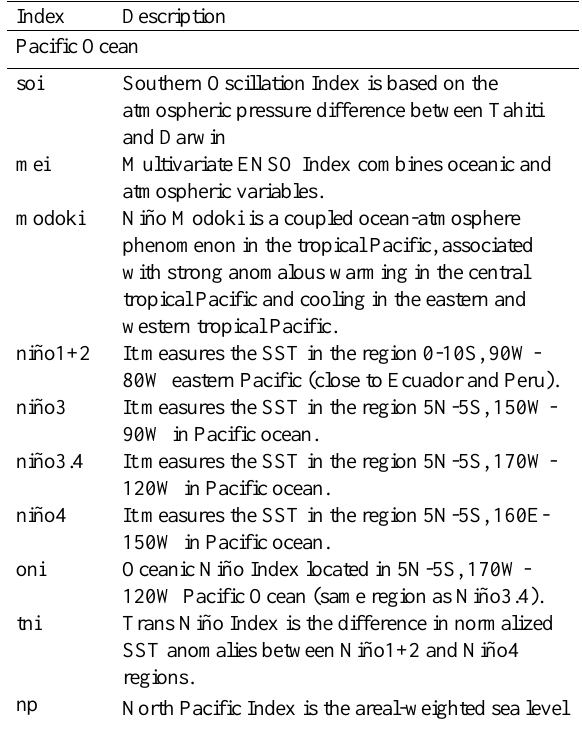
Table 1. Climate indices for teleconnection